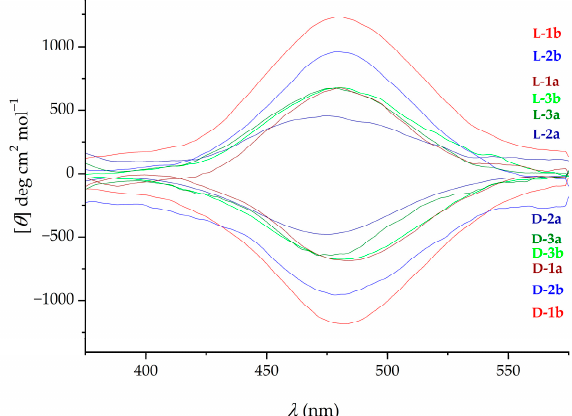
Figure 5. CD spectra of L -/ D - 1a – 3a and L -/ D - 1b – 3b in CH 2 Cl 2 ( c = 1 × 10 − 3